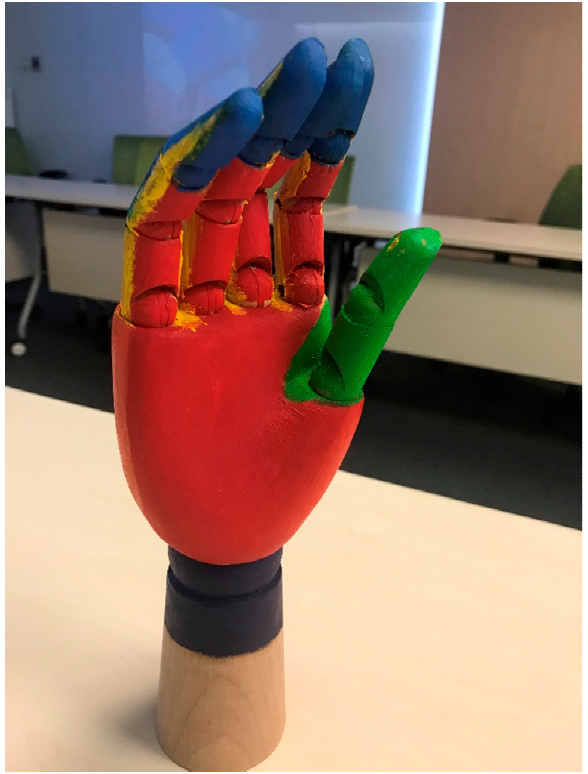
Figure 3. Wooden hand model painted with 7 rainbow colors.